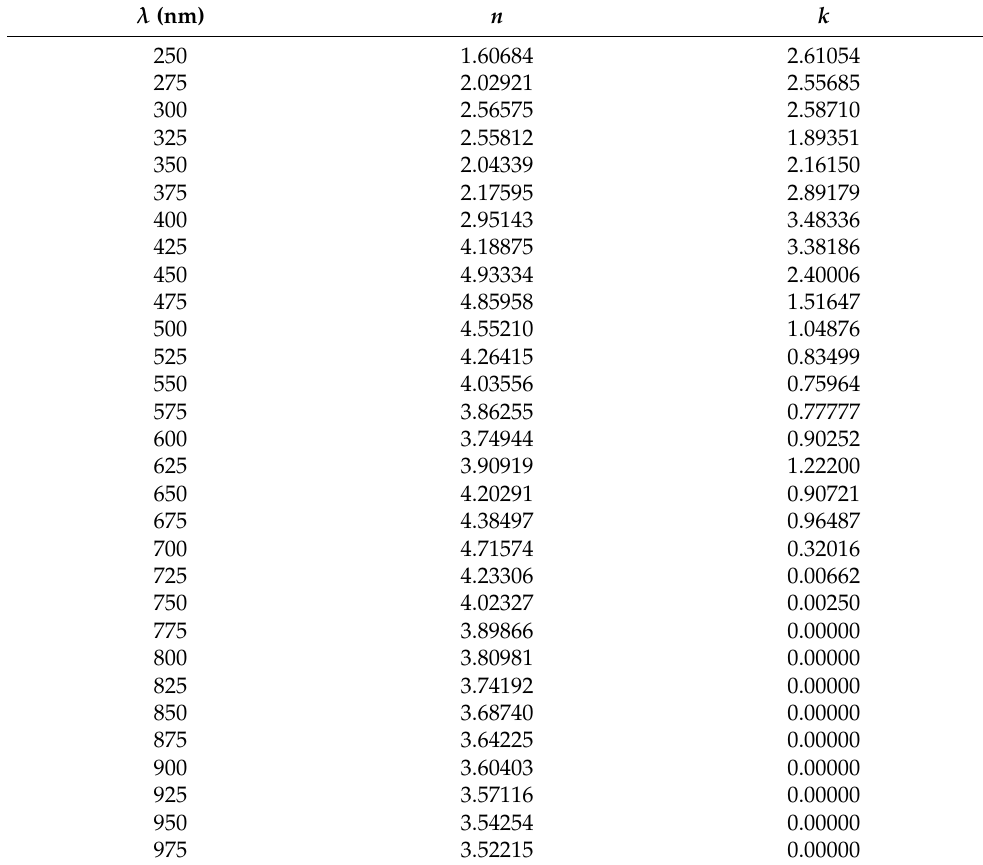
Table A1. Tabulated optical constants for epitaxial MoS 2 monolayer on sapphire